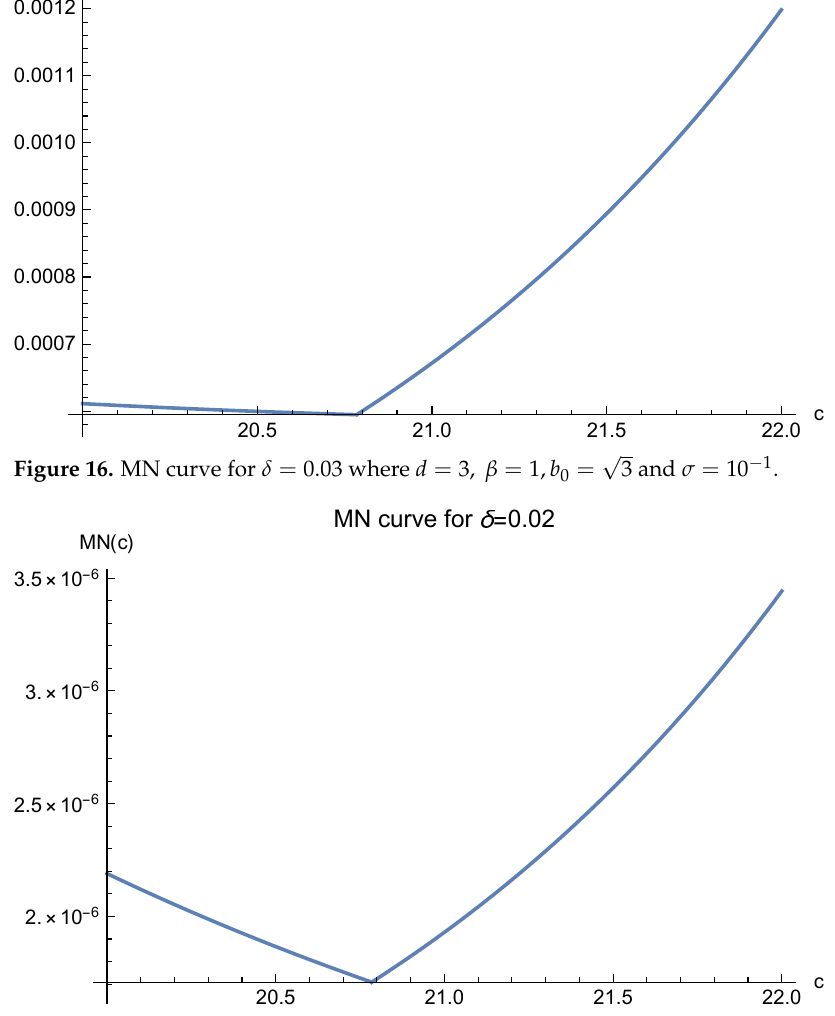
Figure 17. MN curve for δ = 0.02 where d = 3, β = 1, b 0 =